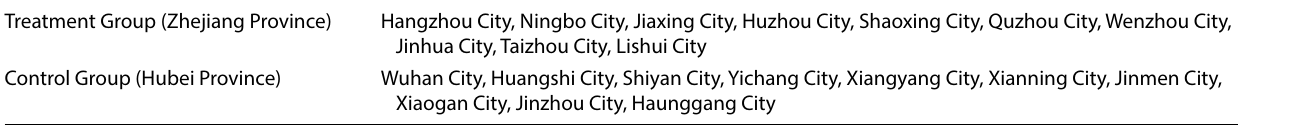
Treatment Group (Zhejiang